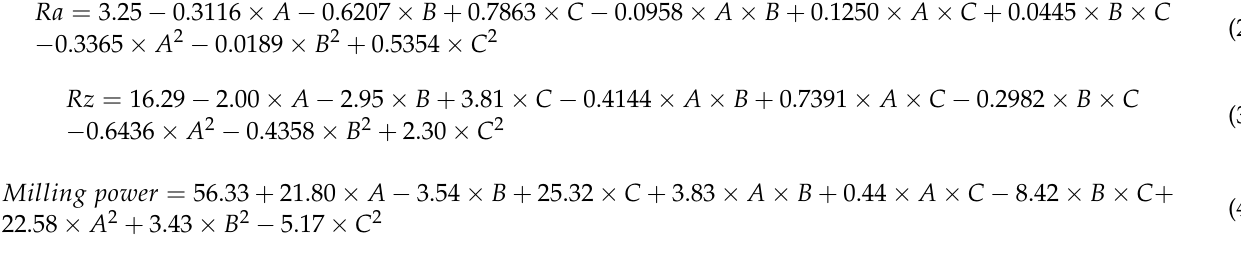
Table 7. Results of ANOVA for the different models.